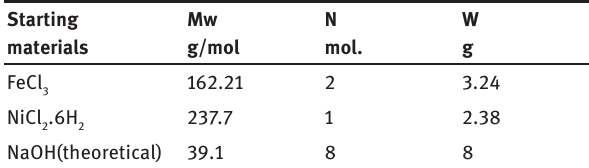
Table 1: Starting material weights for 0.01 mole of Ni ferrites. Where M : molecular weight in gm/mole, N: no. of moles. W: weight in W